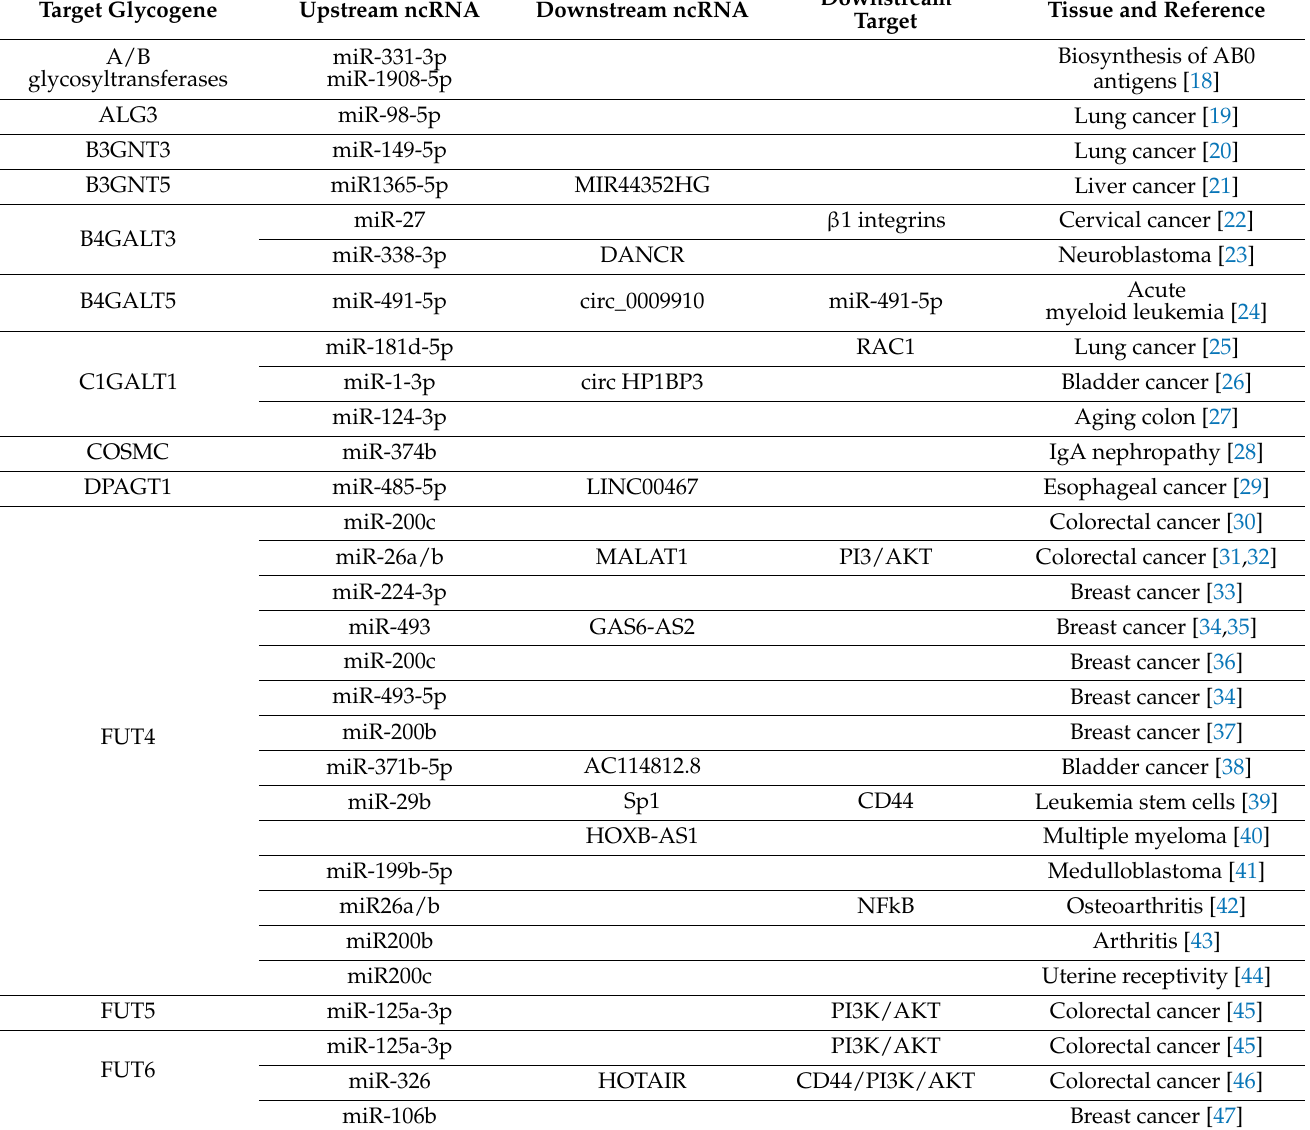
Table 1. Glycogenes modulated by